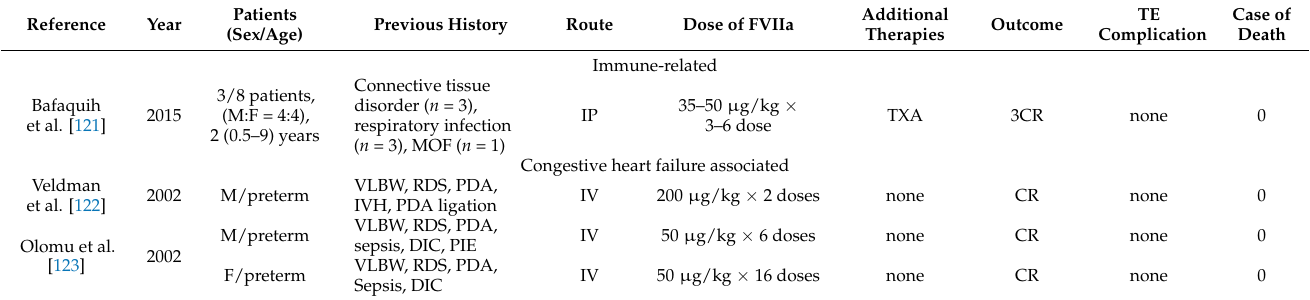
Table 3. Published data on recombinant factor VIIa treatment for diffuse alveolar hemorrhage in children.